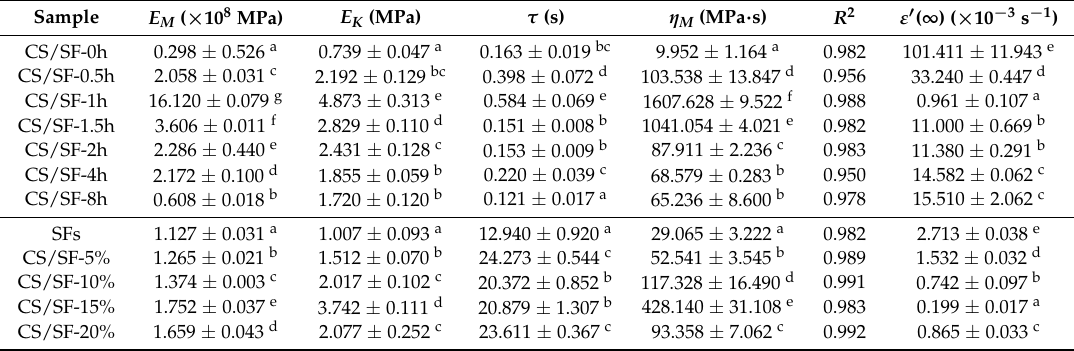
Table 5. The parameters of Burger’s models for the CS/SFs with different ball grinding times and addition